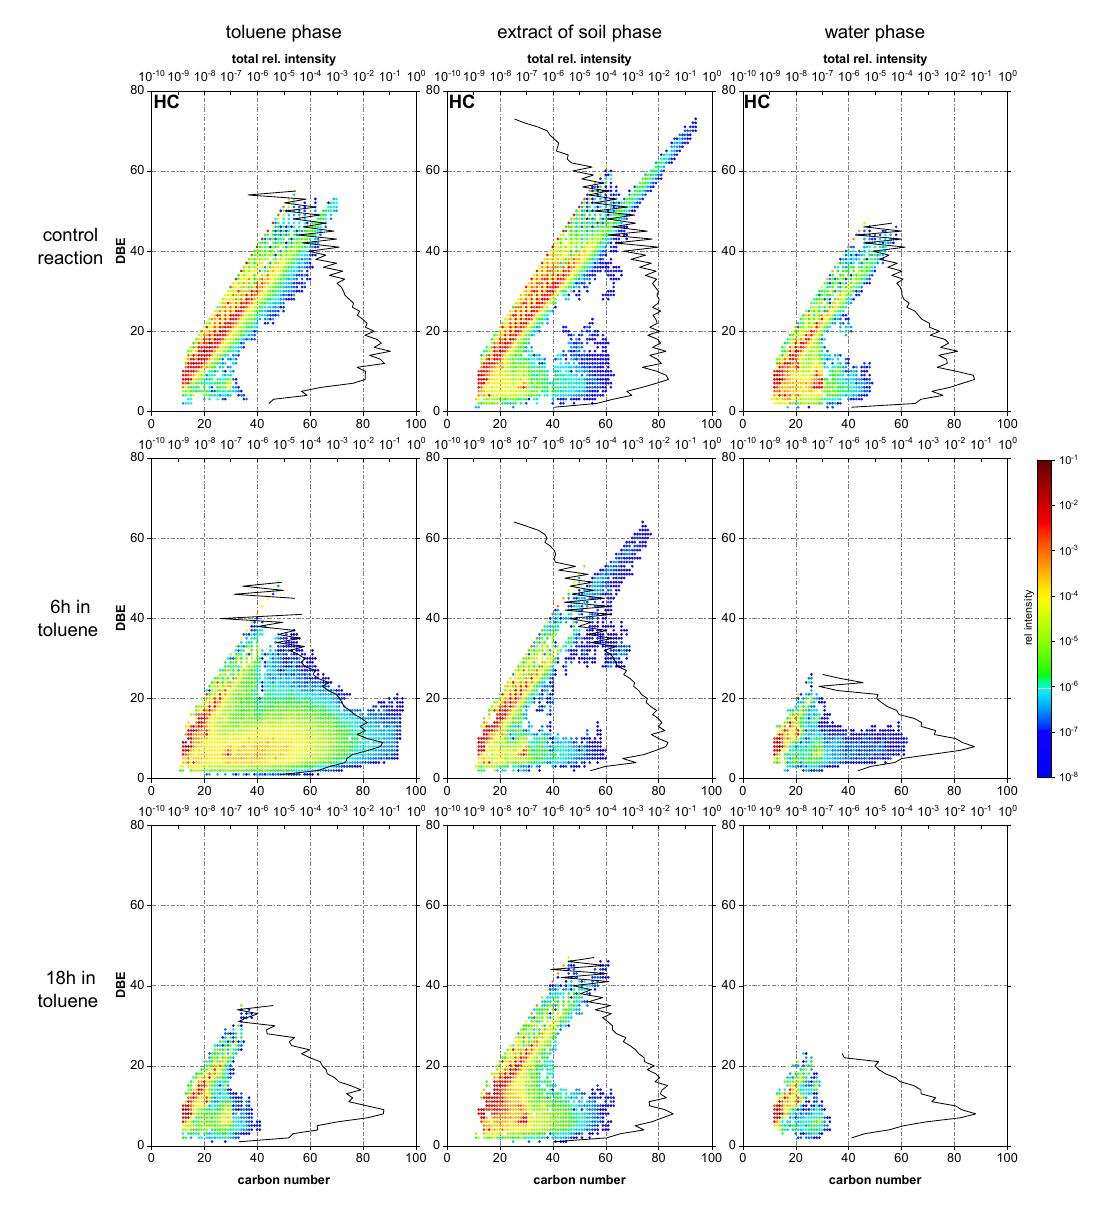
Figure 5. Kendrick plots for HC class in the different phases of control reaction, ozonation within 6 h in toluene and ozonation within 18 h in toluene. The total relative intensity for a given DBE is represented on the upper y-axis, while the number of carbon atoms is plotted on lower y-axis.